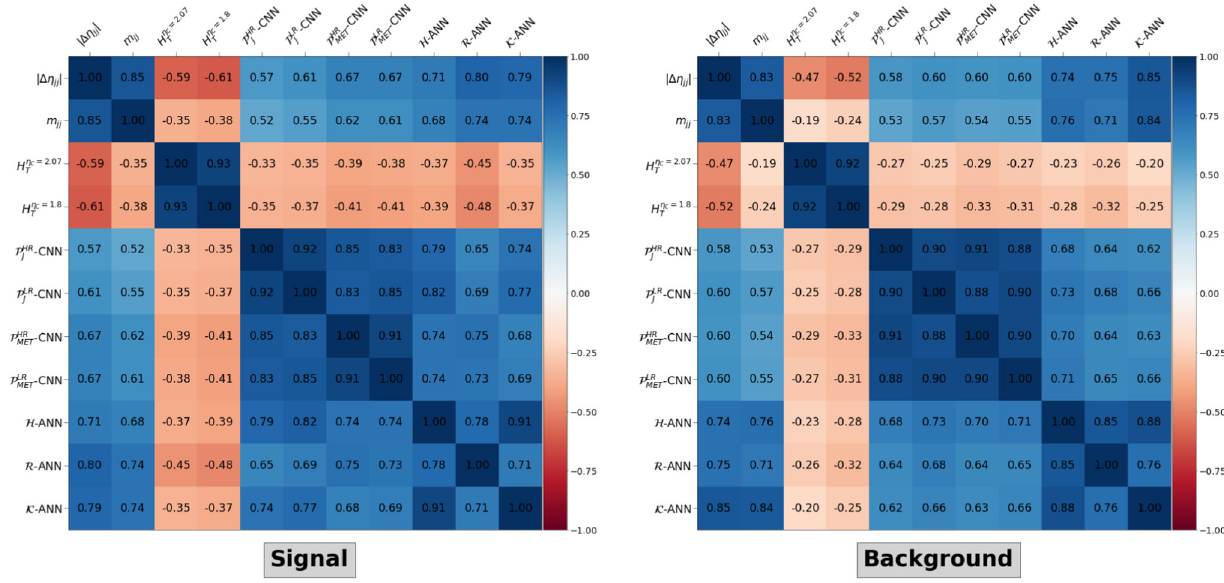
Fig. 13 The validation (top panel) ROC-curves and (bottom panel) training/validation AUC for (left) low-level and (right) high-level fea- ture spaces. In order to compare the feature spaces, the highest perform-